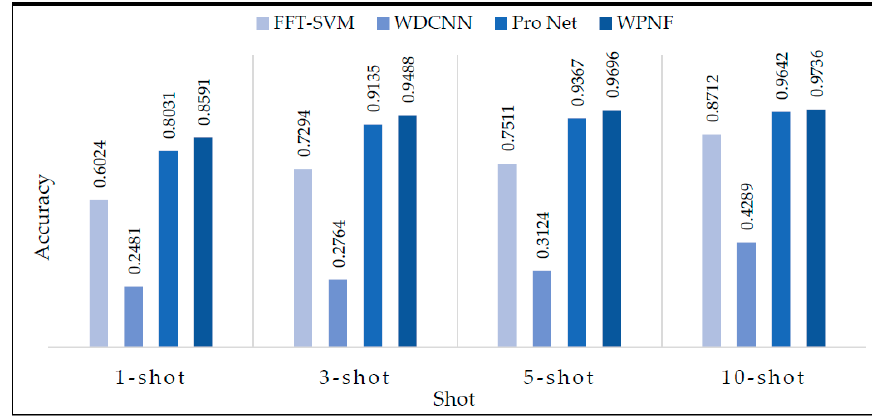
Figure 9. Comparison results of accuracy of models.